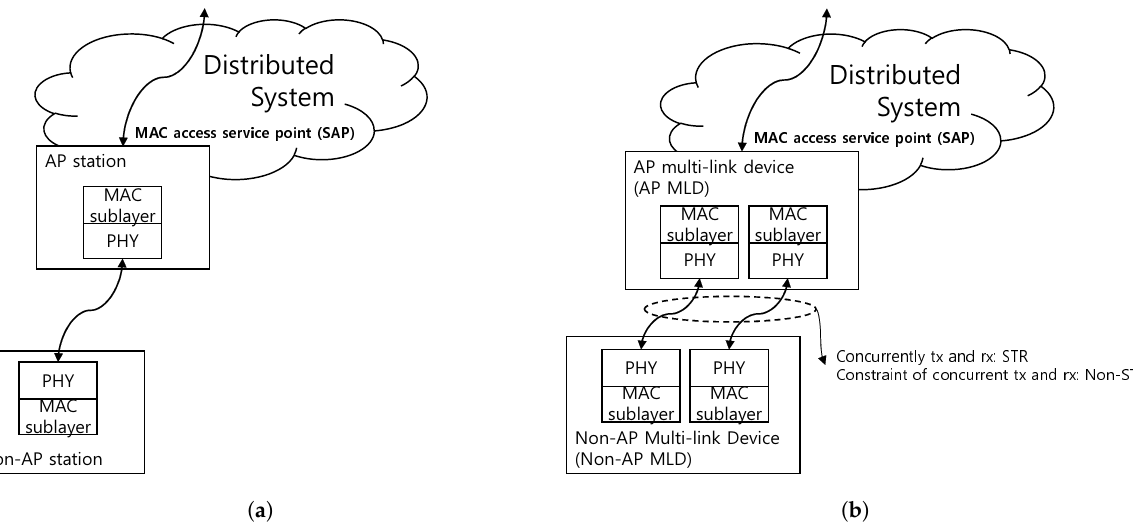
Figure 1. Infrastructure models for conventional IEEE 802.11 and 802.11be. ( a ) Conventional IEEE 802.11 infrastructure model and ( b ) Expected IEEE 802.11be multi-link infrastructure model with multiple